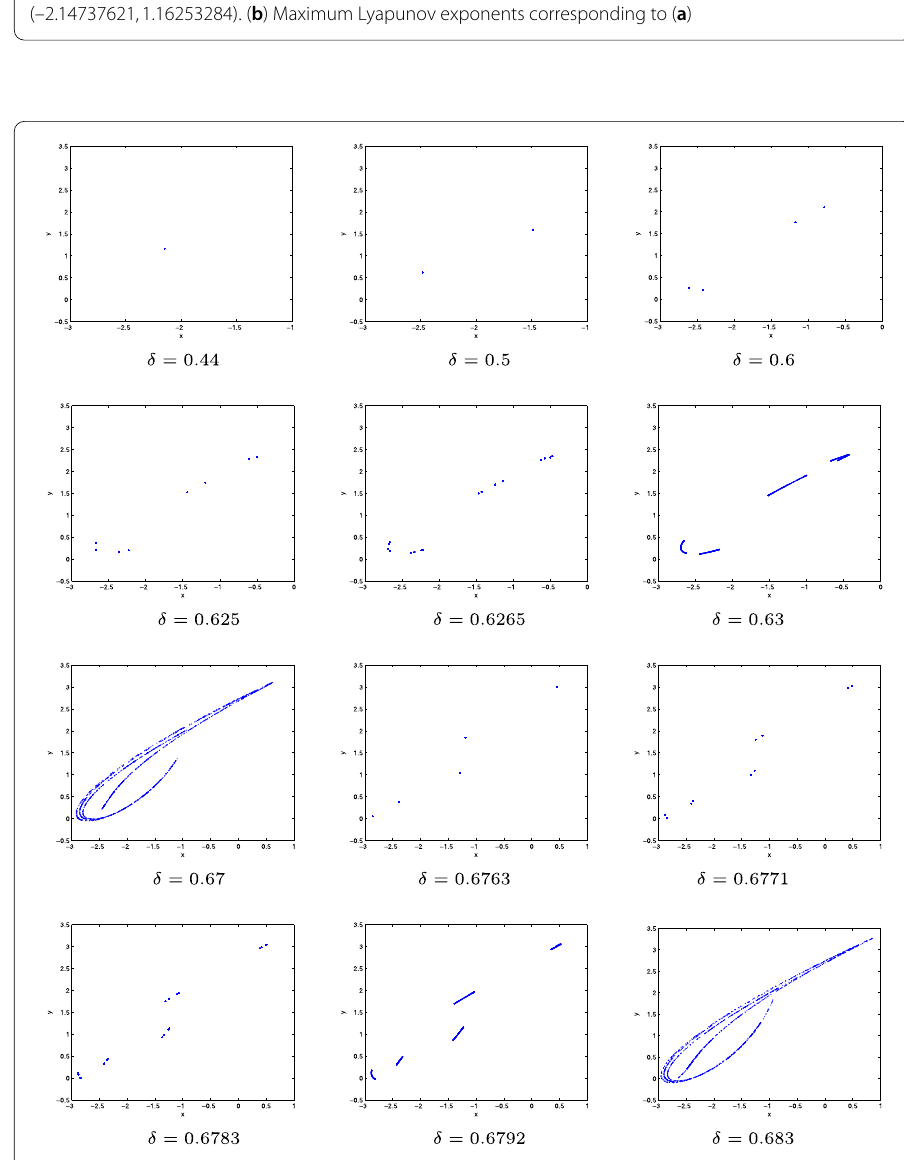
Figure 3 Phase portraits for various values of δ corresponding to Fig.